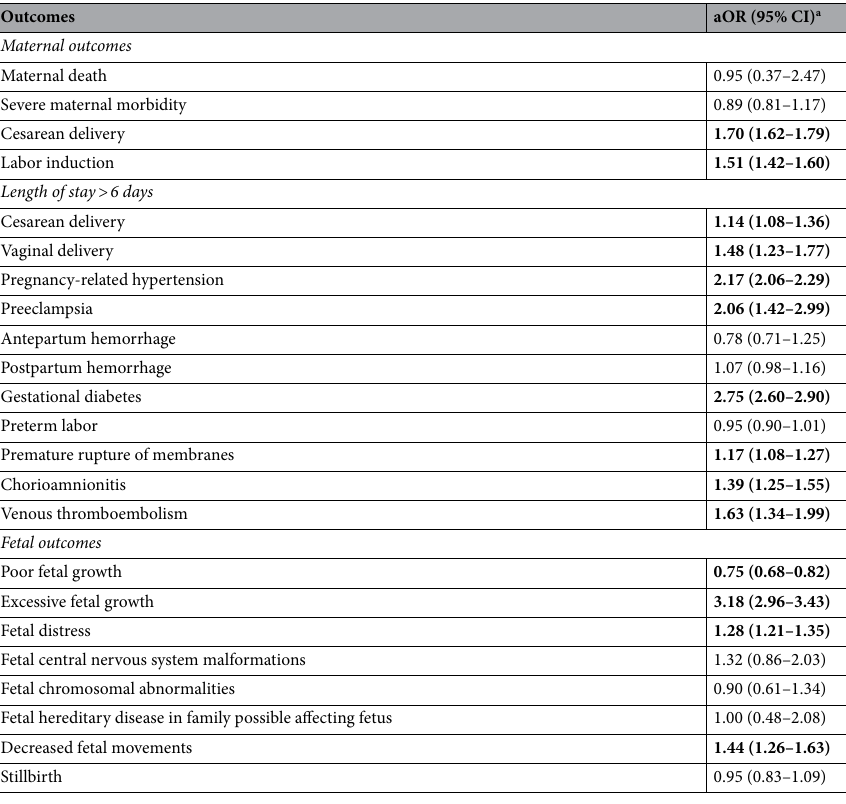
Table 4. Association between obesity and adverse obstetrical outcomes among women who were hospitalized for delivery. a Age, race, insurance, income, hospital region, hospital location, hospital bed size, hospital teaching status, elective admission, multiple births, previous cesarean delivery, preexisting diabetes mellitus, chronic renal disease, preexisting hypertension, depression, alcohol or substance abuse, psychiatric disorders, liver disease, chronic pulmonary disease, maternal death, severe maternal morbidity, cesarean delivery, labor induction, length of stay > 6 days, pregnancy-related hypertension, preeclampsia, antepartum hemorrhage, postpartum hemorrhage, gestational diabetes, preterm labor, premature rupture of membranes, chorioamnionitis, venous thromboembolism, poor fetal growth, excessive fetal growth, fetal distress, fetal central nervous system malformations, fetal chromosomal abnormalities, fetal hereditary disease in family, decreased fetal movements, and